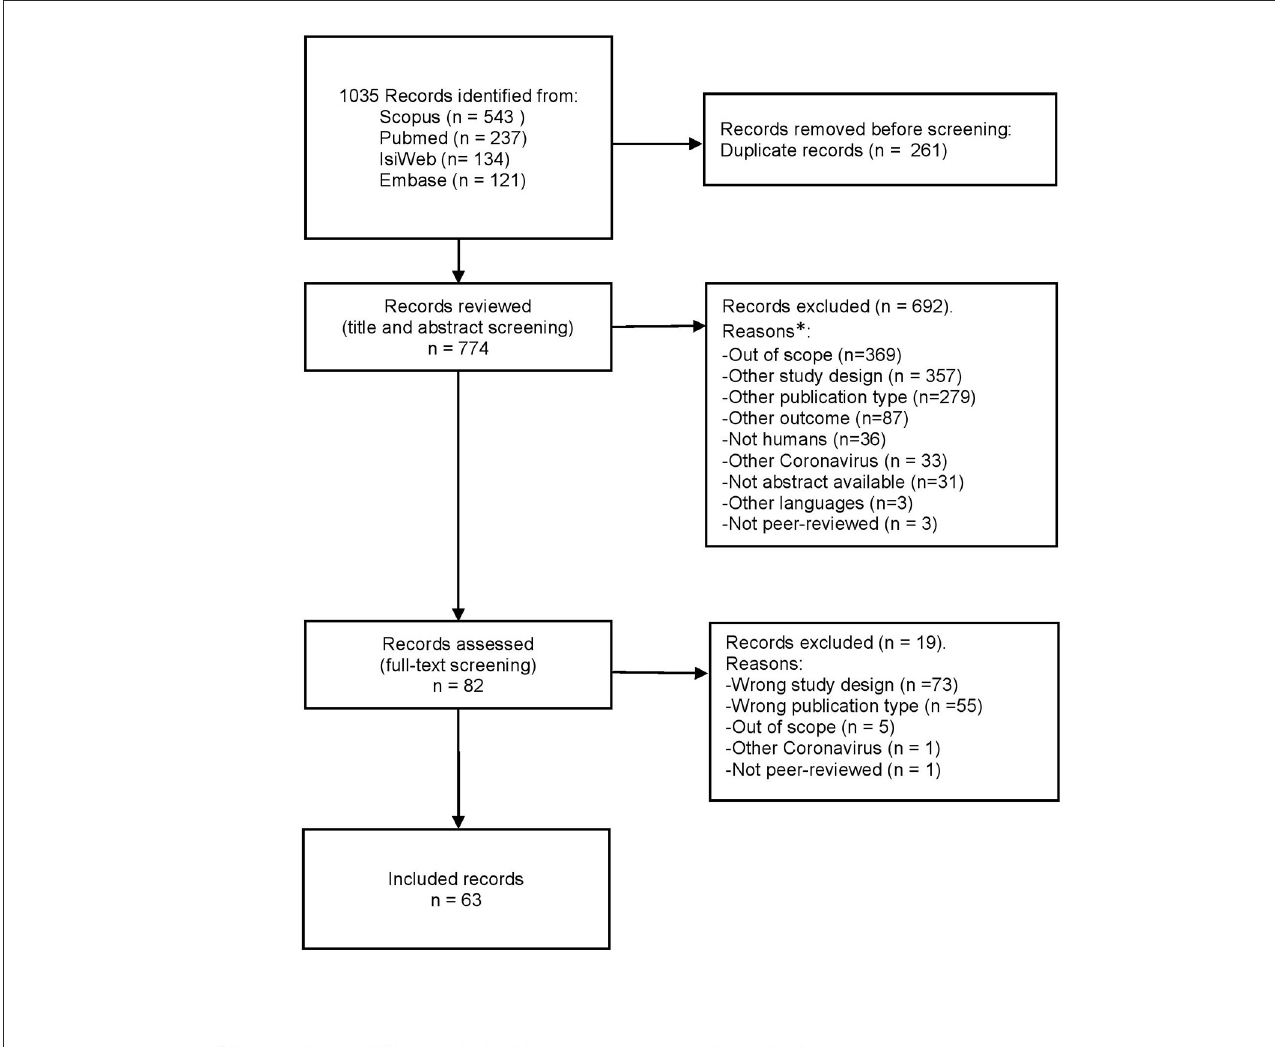
FIGURE1 PRISMA guidelines flow